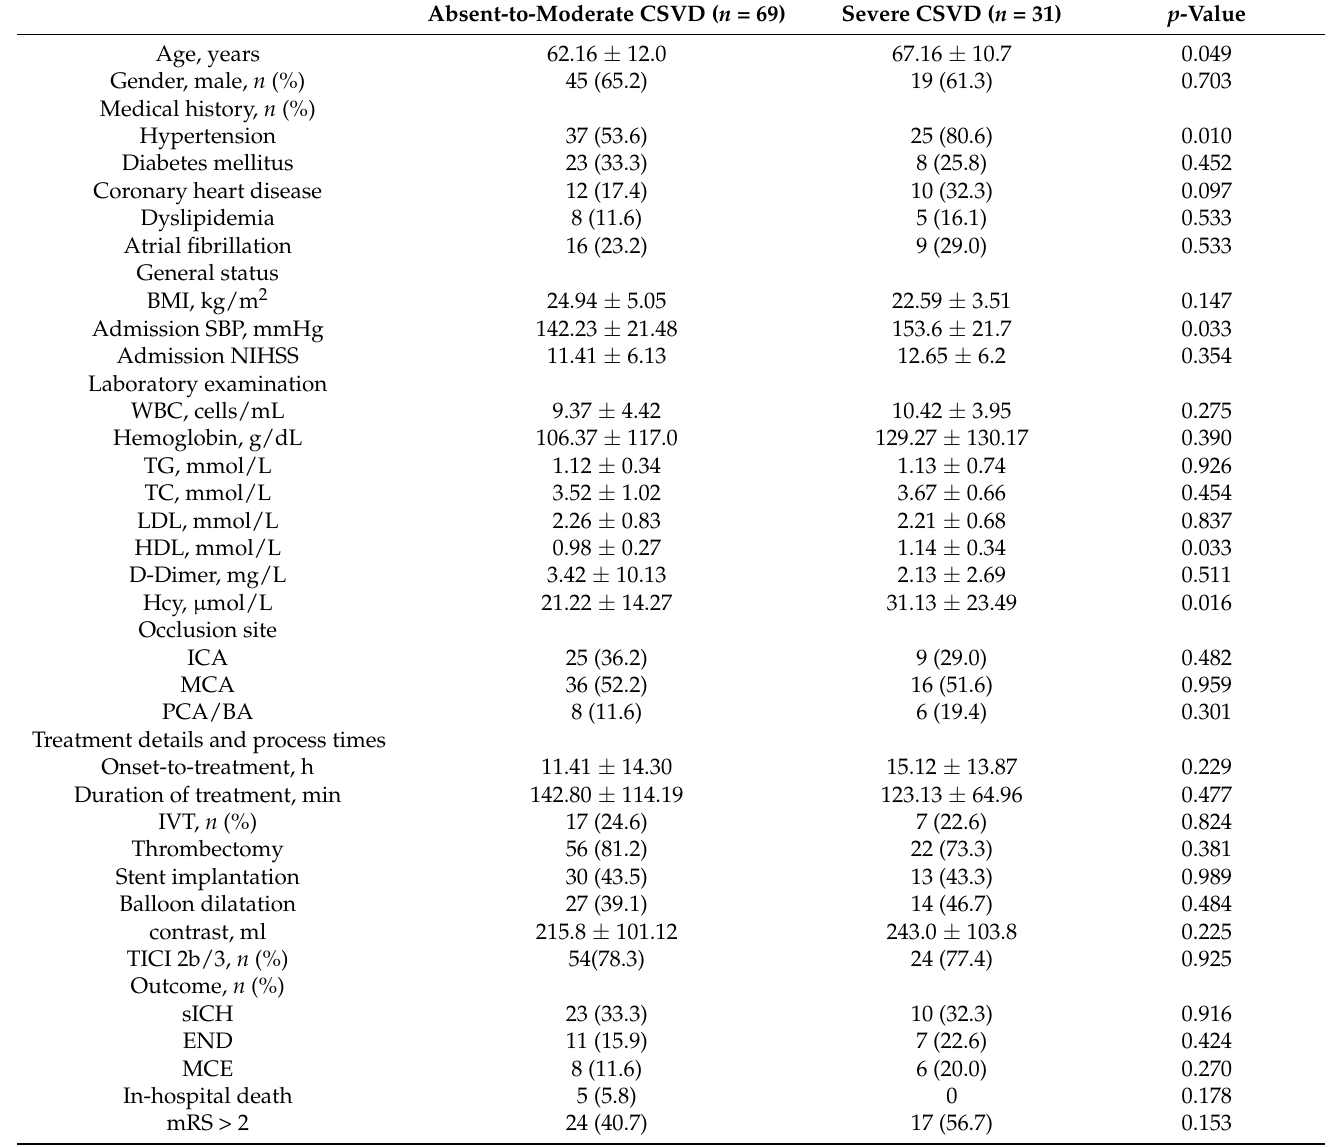
Table 2. Baseline characteristics of the patients according to the overall CSVD burden. Absent-to-Moderate CSVD ( n =